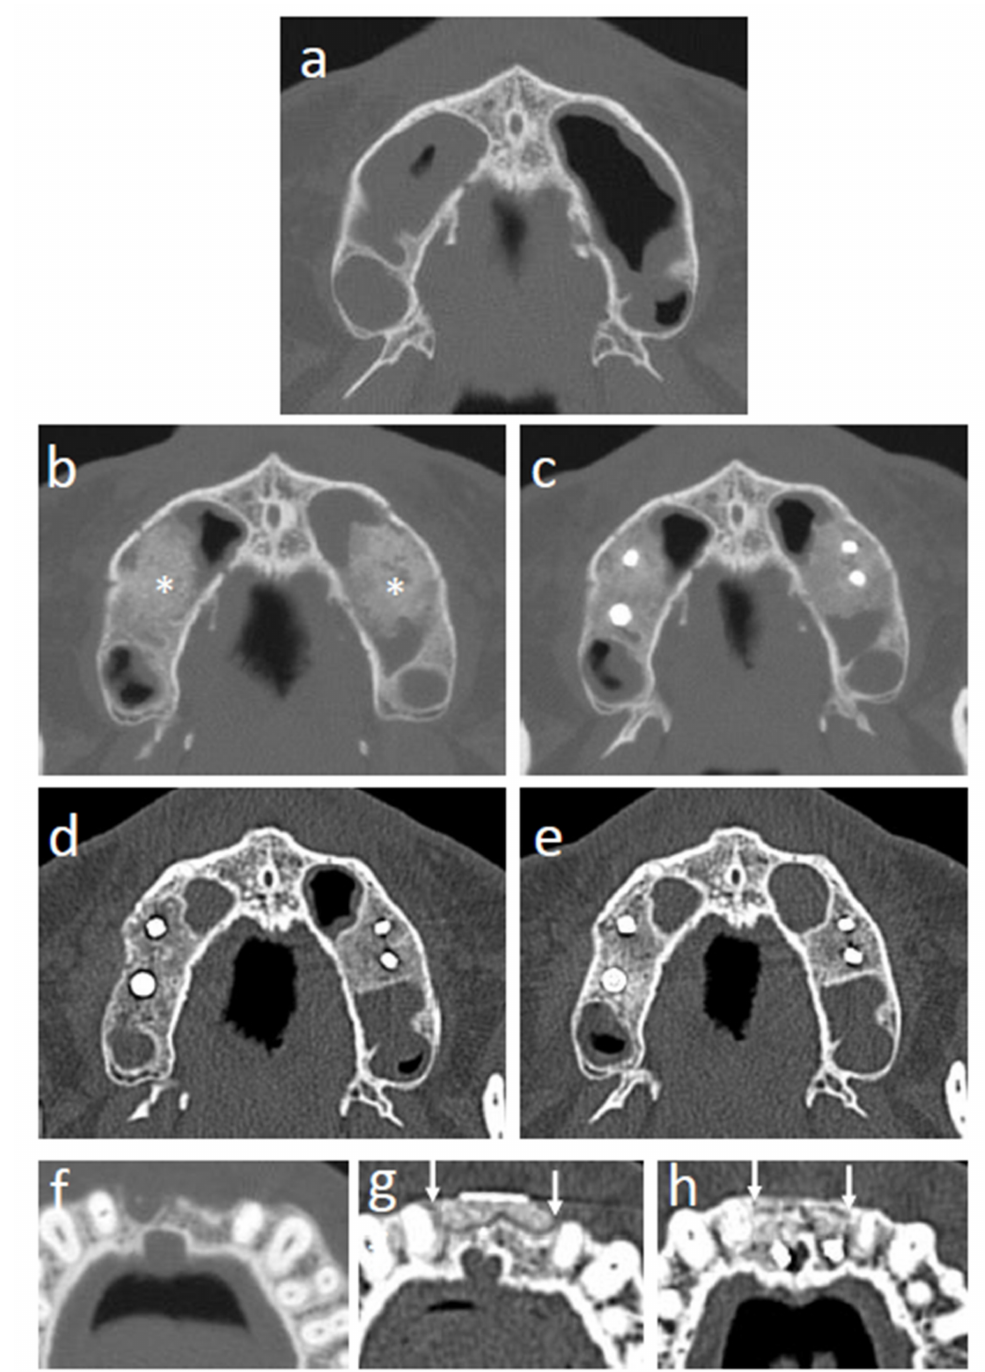
Figure 6. CT images of regenerating sites. ( a ) Sinus floor augmentation case before transplantation. ( b ) Sinus floor augmentation case at 3 months after transplantation (* shows the transplanted tissue- engineered bone). ( c ) Sinus floor augmentation case at 6 months after transplantation. ( d ) Sinus floor augmentation case at 12 months after transplantation. ( e ) Sinus floor augmentation case at 24 months after transplantation. ( f ) Alveolar ridge augmentation case before transplantation. ( g ) Alveolar ridge augmentation case at 3 months after transplantation (white arrows indicate the area of transplanted tissue-engineered bone). ( h ) Alveolar ridge augmentation case at 24 months after transplantation (white arrows indicate the area of transplanted tissue-engineered